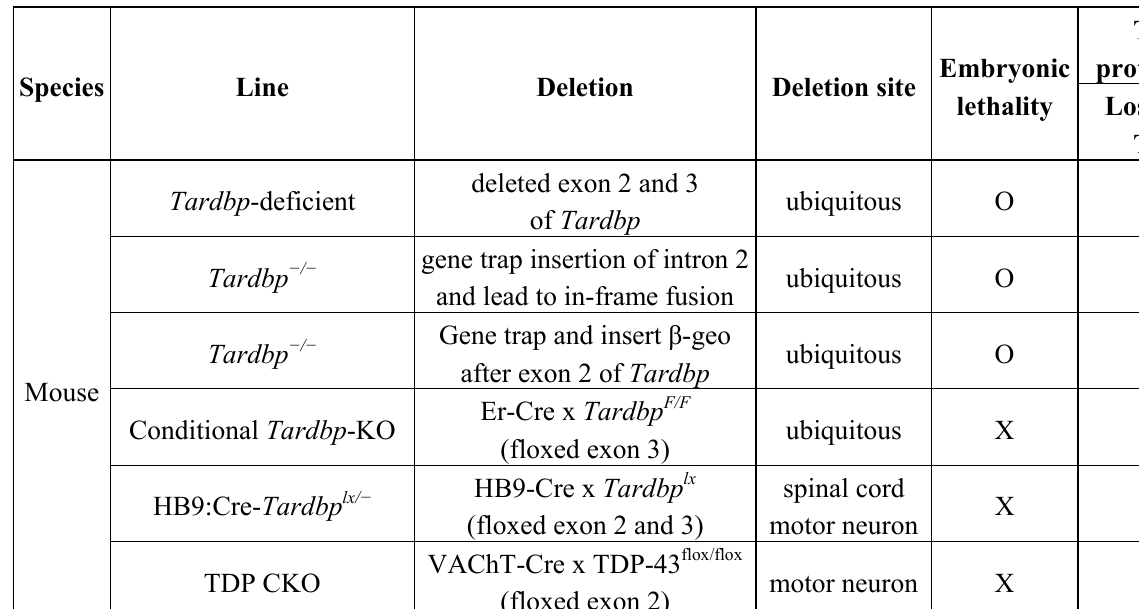
Table 3. Mammalian model: TDP-43 knockout model (NA: